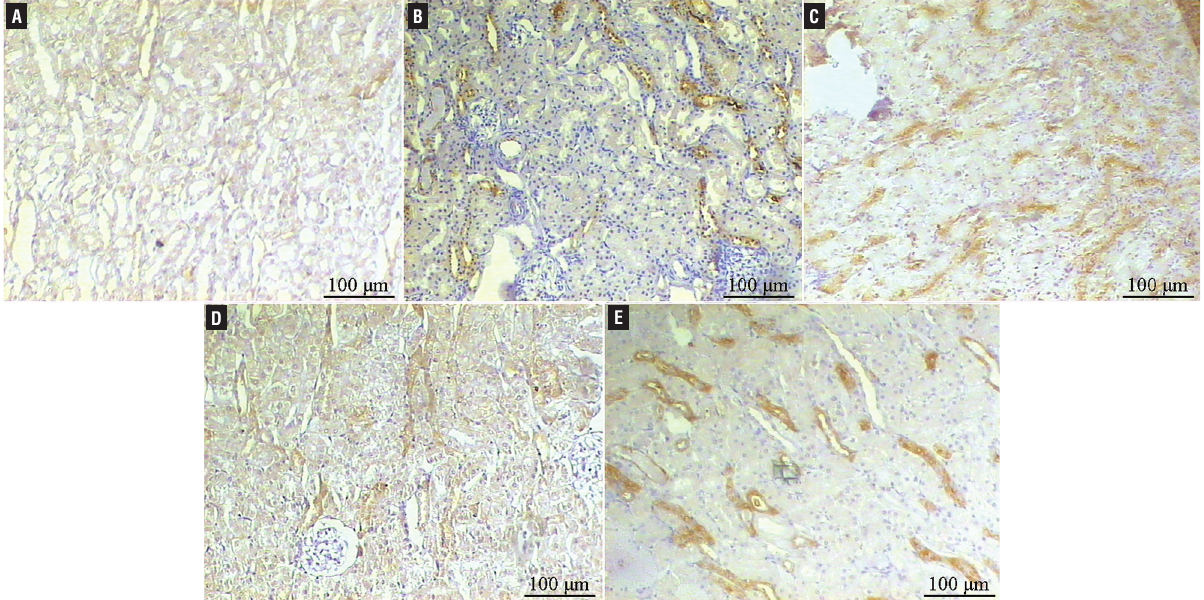
Figure 2 - Expression of ICAM-1 in renal tissue detected by immunohistochemistry